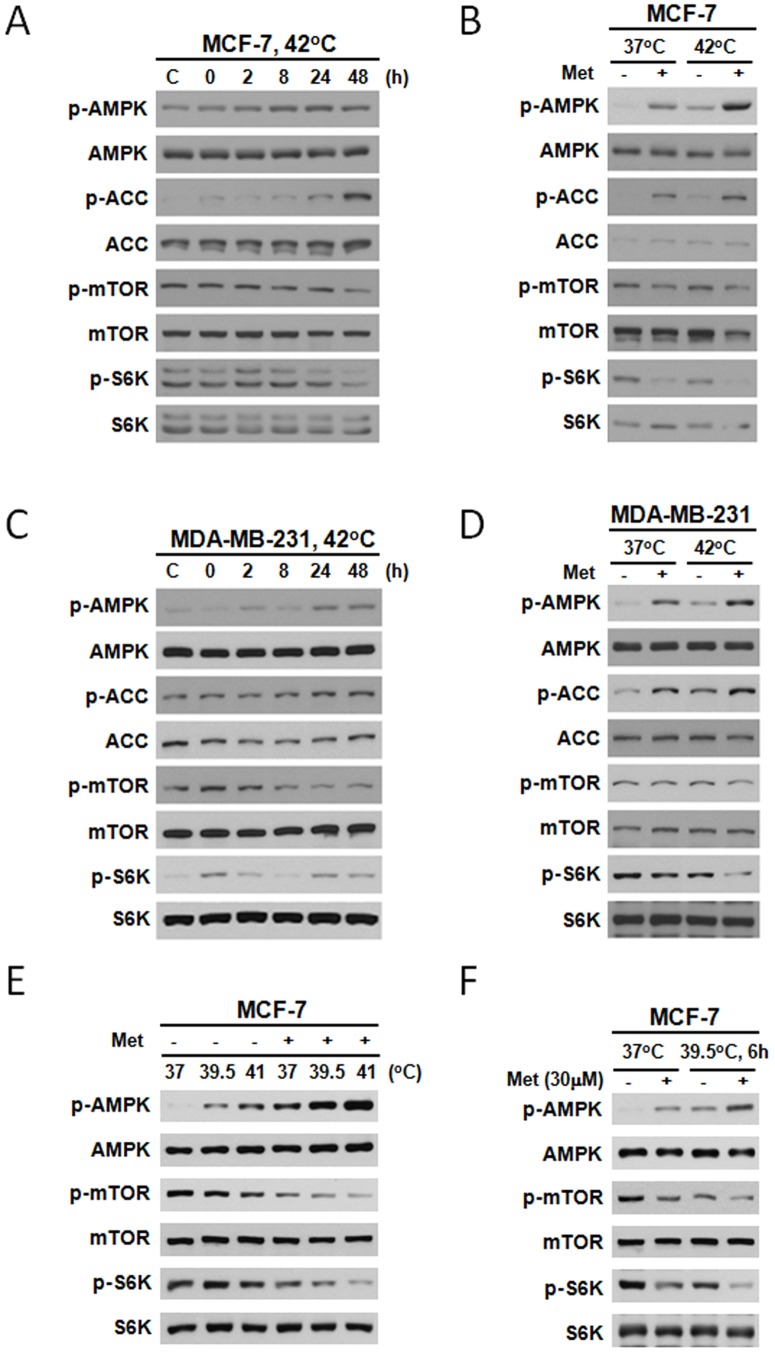
Western blotting of AMPK/mTOR pathway in MCF-7 and MDA-MB-231 cells treated with hyperthermia and metformin.(A, C) Cells were heated at 42°C for 1 h and then incubated at 37°C for 47 h (total 48 h treatment). (B, D) The effects of metformin alone were studied by incubating cells with 5 mM metformin for 48 h at 37°C. The combined effects of metformin and heating were studied by heating the cells at 42°C for 1 h with 5 mM metformin and then incubating at 37°C for 47 h. (E) The combined effects of metformin and heating were studied by heating the cells at 39.5–41°C for 1 h with 5 mM metformin and then incubating at 37°C for 47 h. (F) The combined effects of metformin and heating were studied by heating the cells at 39.5°C for 6 h with 30 µM metformin and then incubating at 37°C for 47 h. Experiments were repeated 4–5 times and the representative results are shown.